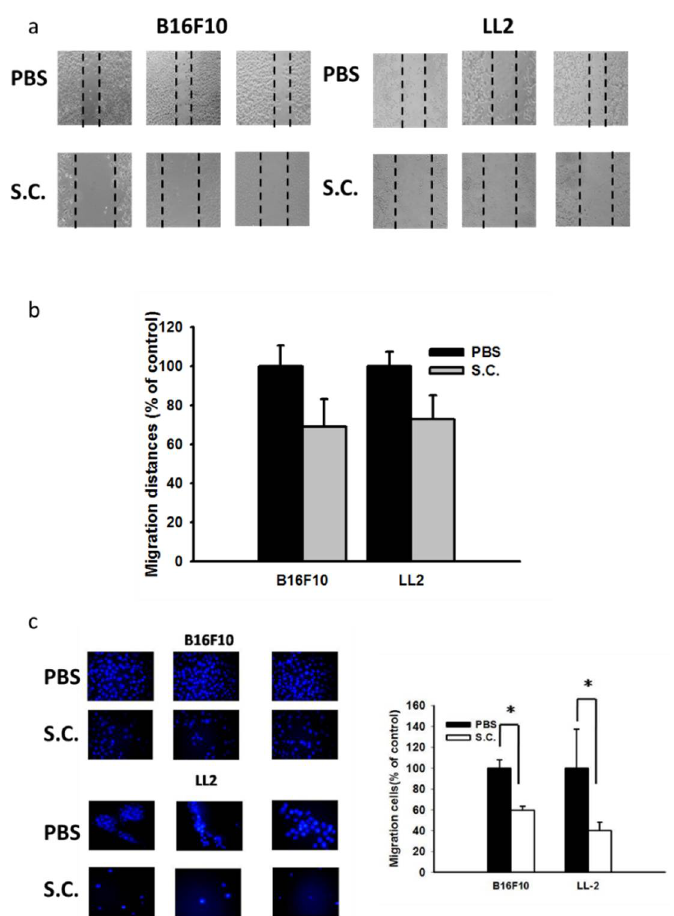
Figure 1. Effects of Salmonella (S.C.) on cellular migration in B16F10 and LL2 cells. B16F10 cells and LL2 cells (2 × 10 5 cells/well) were placed onto plates and incubated at 37 ◦ C for 24 h. The cells cocultured with Salmonella (Multiplicity Of Infection (MOI) = 10) for 4 h. The migration distances of different groups of B16F10 and LL2 cells were shown ( a ) and measured ( b ) ( × 400); ( c ) Tumor cells were placed on the upper layer of a cell culture insert with permeable membrane and then treated with Salmonella (MOI = 10) for 4 h. Following an incubation 24 h, the cells migrated through the membrane were stained with 4 (cid:48) ,6-Diamidino-2-Phenylindole (DAPI) and counted under a fluorescence microscope ( ×